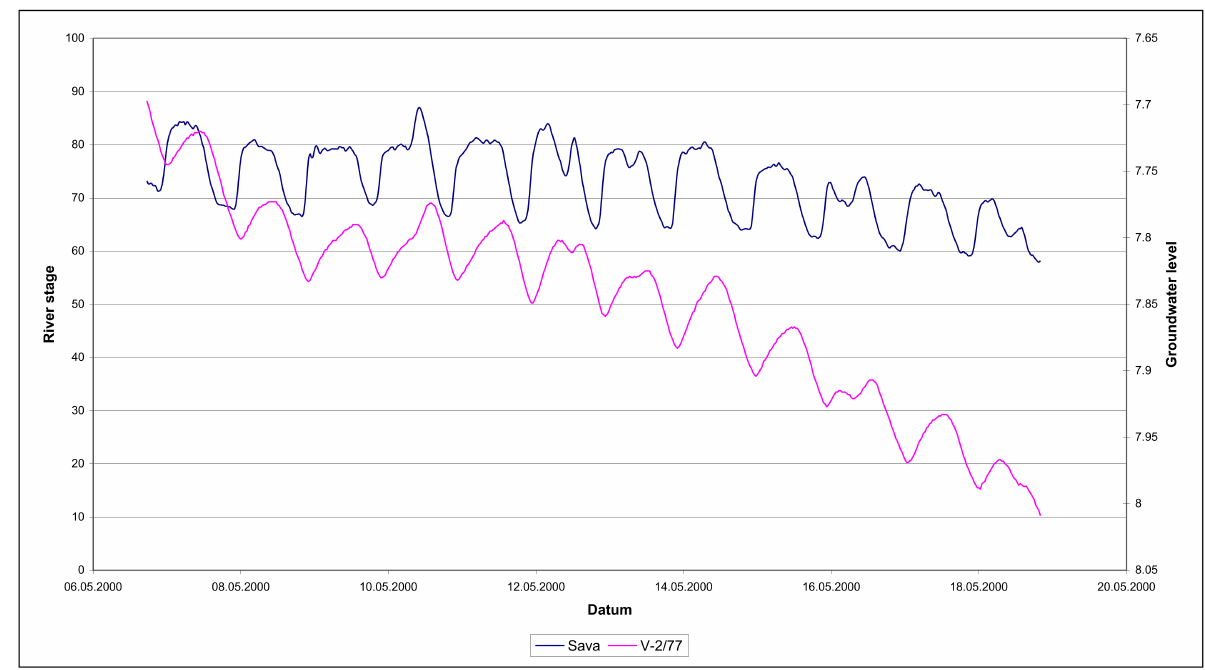
Figure 3. Oscillation of groundwater levels and levels of the NEK river